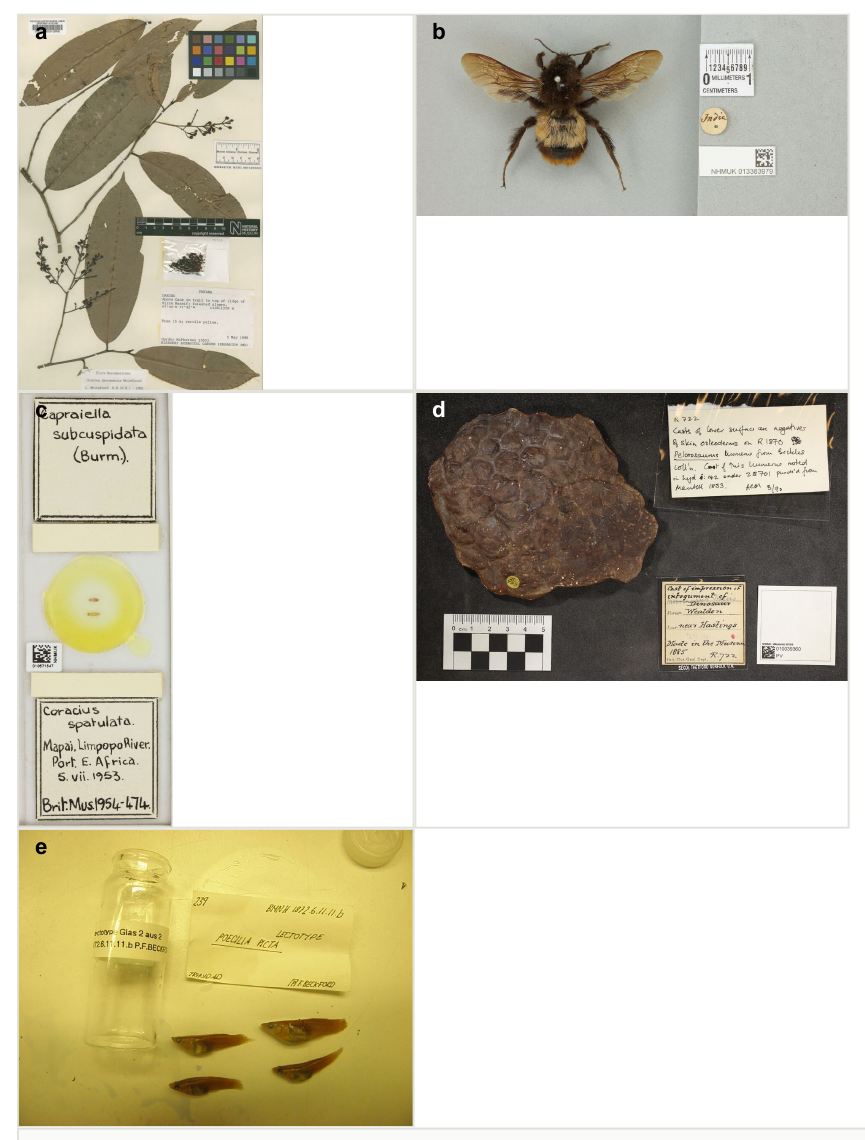
A range of sample specimens that demonstrate the wide taxonomic range of specimens encountered in collections. They also demonstrate the diversity of label types, which include handwritten, typed, and printed labels. Note the presence of various barcodes, rulers, and a colour chart in addition to labels describing the origin of the specimen and its